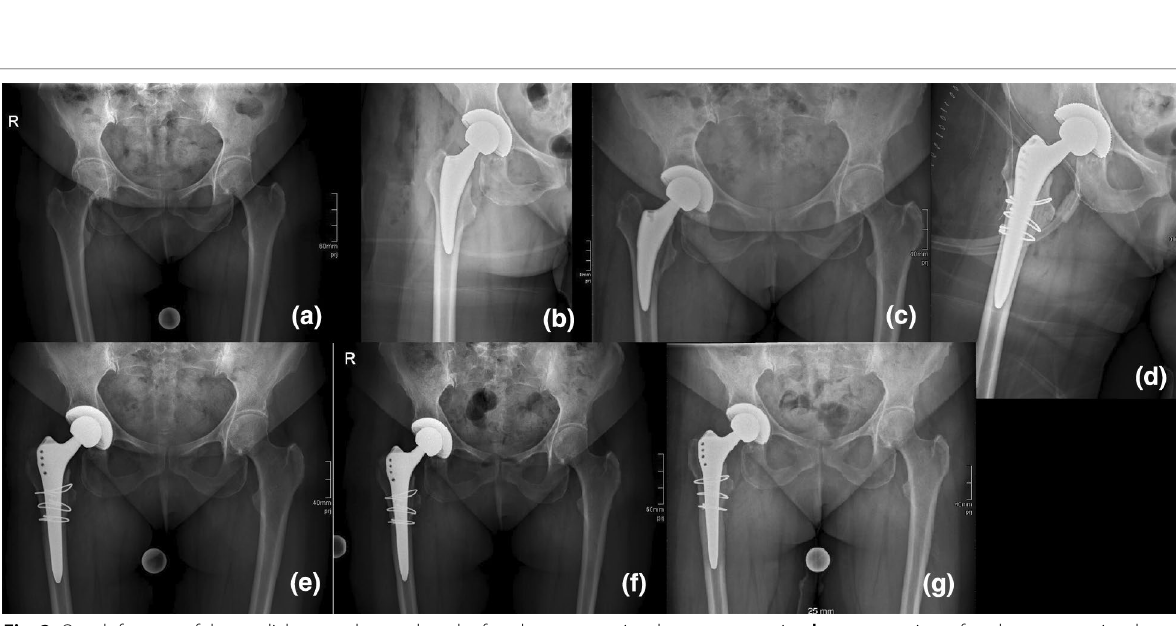
Fig. 2 Occult fracture of the medial cortex detected on the fourth postoperative day; a preoperative; b postoperative; c fourth postoperative day; d postoperatively after revision (Alloclassic SL (ZimmerBiomet) with three cerclage wires); e 6 weeks after revision; f 3 months after revision; g 1 year after